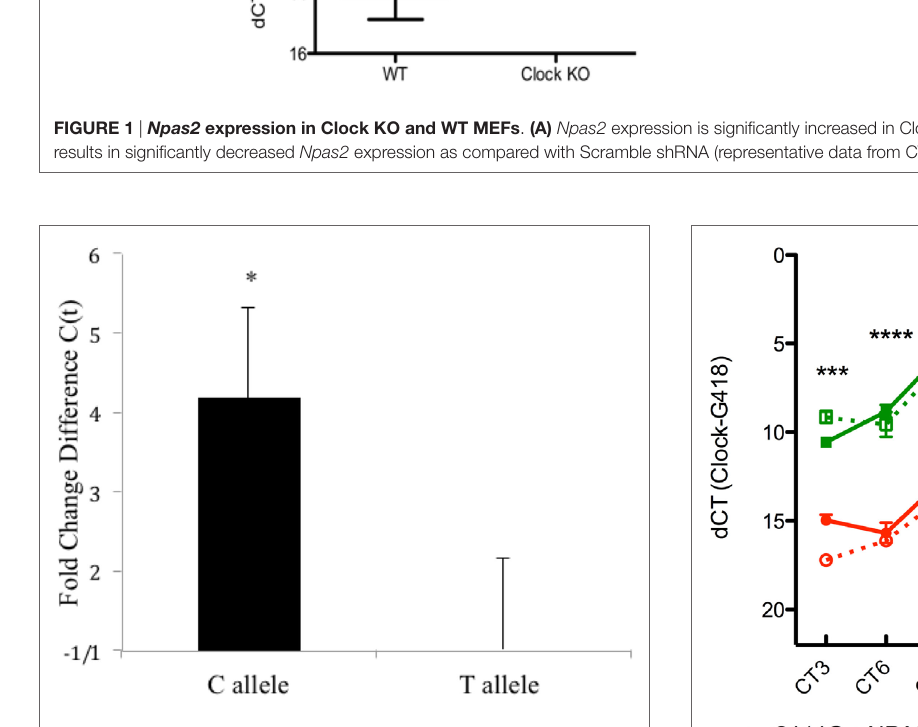
FigUre 2 | Fold change difference in hCLOCK levels in Clock 3111T/c-expressing MeFs (single time point) . Clock 3111C gene expression is significantly higher than 3111T expression. * P <